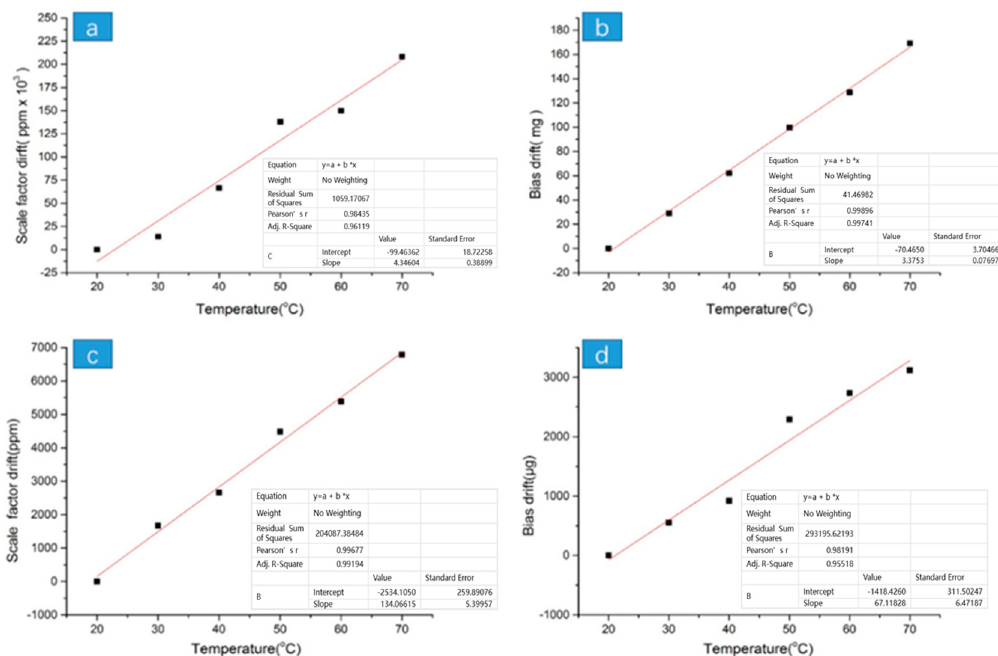
Table 5. The test results of the temperature drift of bias (TDB) and temperature drift of scale factor (TDSF).